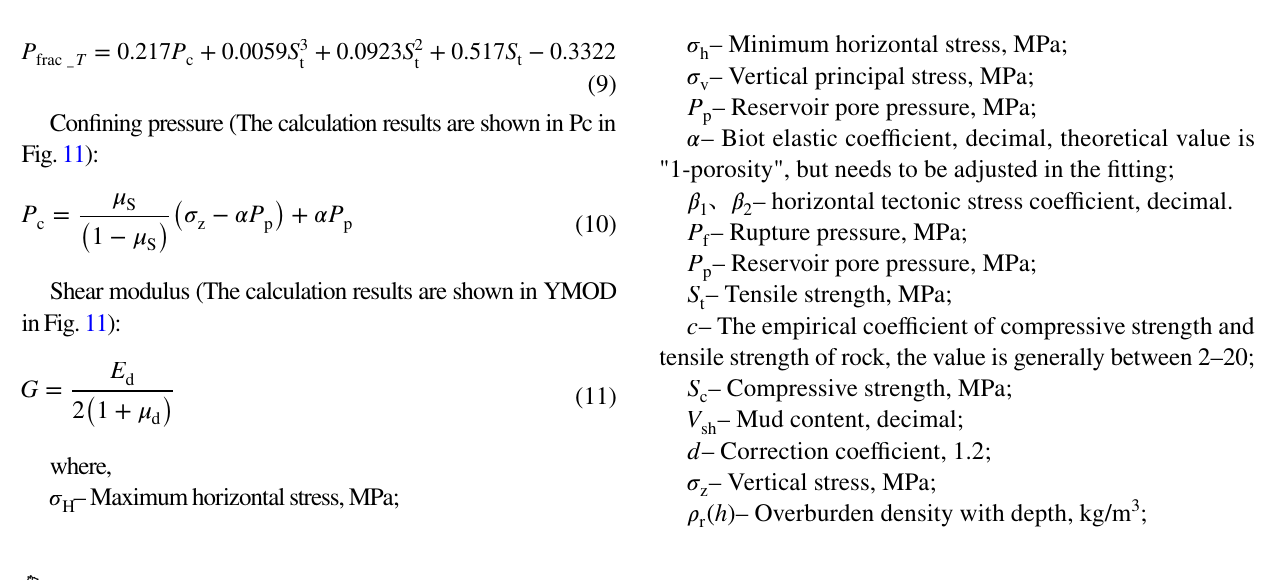
Fig. 5 Shear wave prediction calculation results based on a neural network